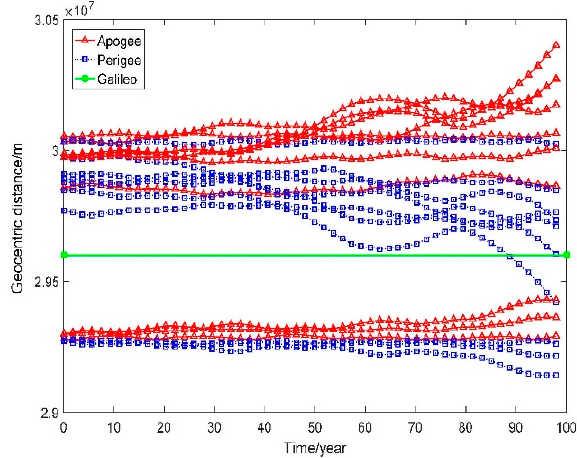
Figure 5. Orbital variations of Galileo spent upper stages over 100 years.